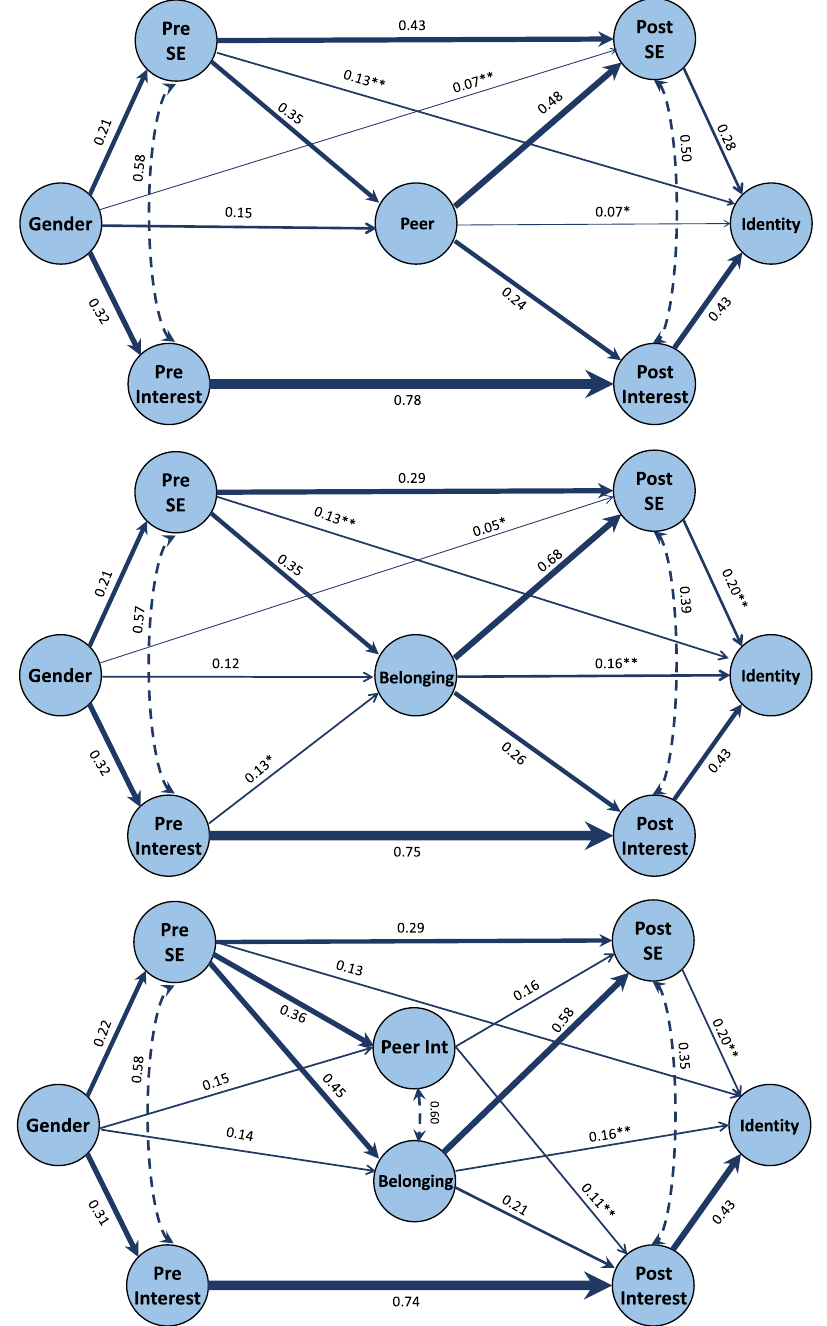
FIG. 6. Schematic diagram of the path analysis part of the structural equation modeling of perception of learning environment models including only peer interaction, only sense of belonging and both peer interaction and sense of belonging. The solid lines represent regression paths, and the dashed lines represent residual covariances. The regression line thickness corresponds to the magnitude of β value (standardized regression coefficient) with 0 . 01 < p < 0 . 05 indicated by * and 0 . 001 < p < 0 . 01 indicated by **. Other regression lines show relations with p < 0 . 001